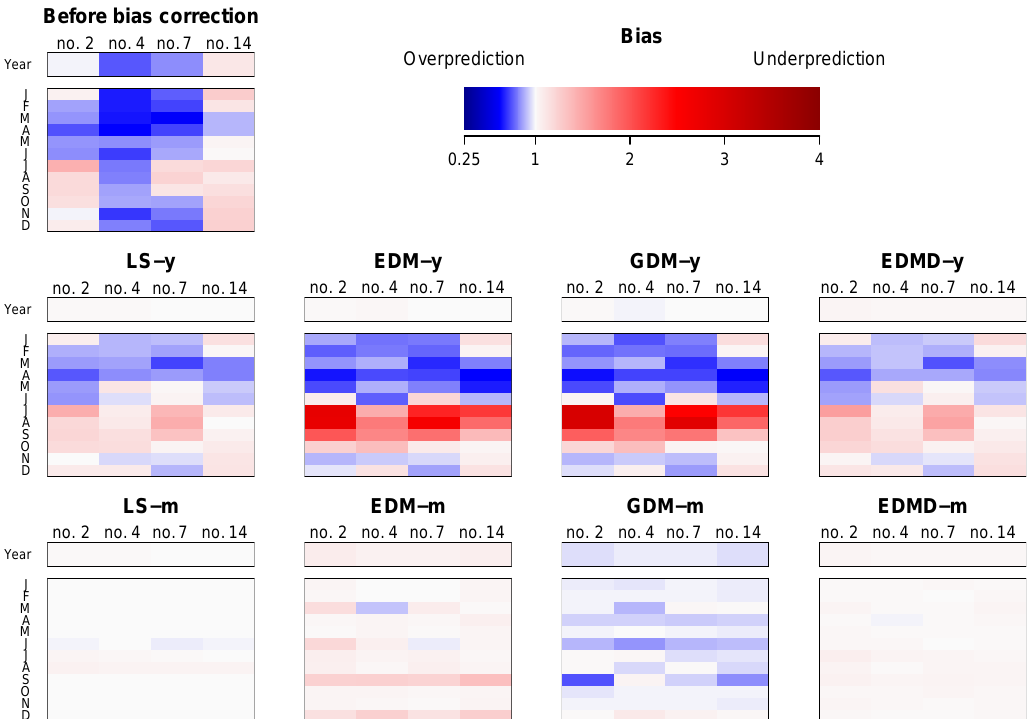
Figure 6. Bias in precipitation for catchments 2, 4, 7 and 14, over the 1981–2010 period. The bias is shown for the whole year (top line) and for each calendar month. The bias is only shown for lead times between 31 and 60 days. Blue-shaded areas represent a tendency of overpredicting precipitation, and red-shaded areas represent a tendency of underpredicting precipitation. The top left graph represents the bias of raw precipitation forecasts, and each of the other graphs represents the bias after applying one of the bias correction